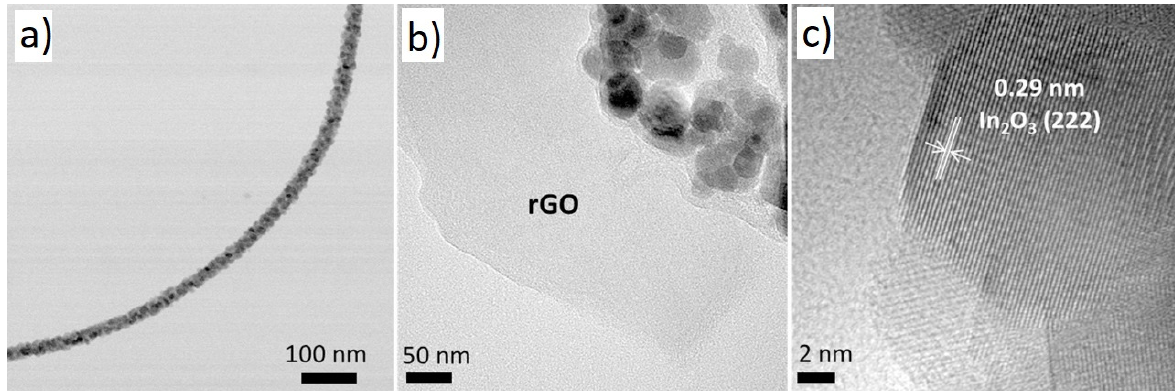
Figure 15. ( a ) Typical TEM image of rGO-loaded In 2 O 3 NF. ( b ) TEM image showing rGO and ( c ) High-resolution TEM showing fringe of In 2 O 3 [75].